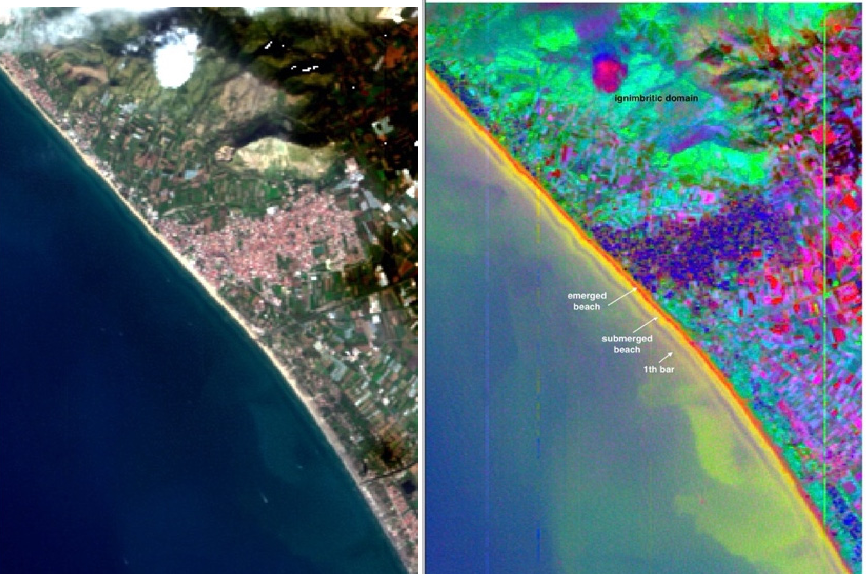
Figure 13. Sinuessa RGB ( left ) and PCA ( right ) images: the VNIR PRISMA dataset highlighted the geo ‐ morphological characteristics of the study area in the continental and coastal area.